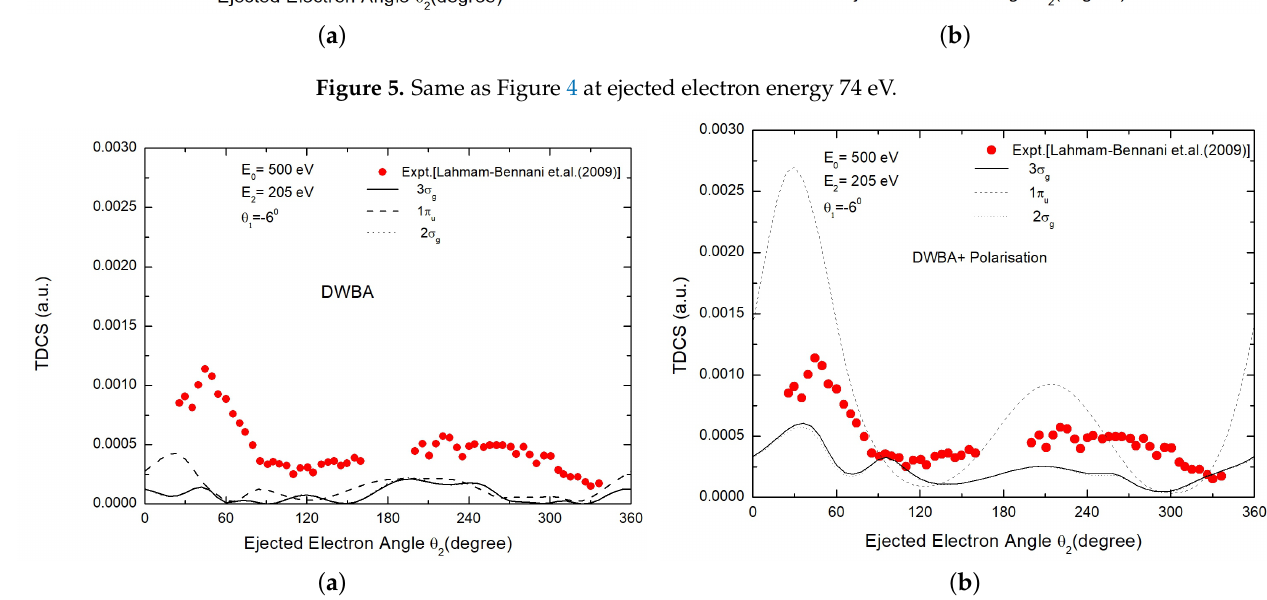
Figure 6. Same as Figure 4 at ejected electron energy 205